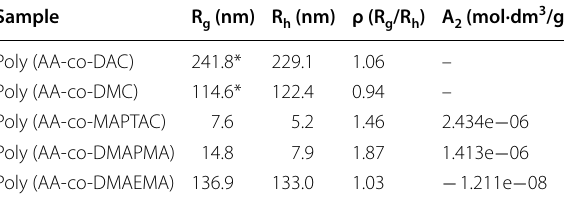
*Apparent radius of gyration